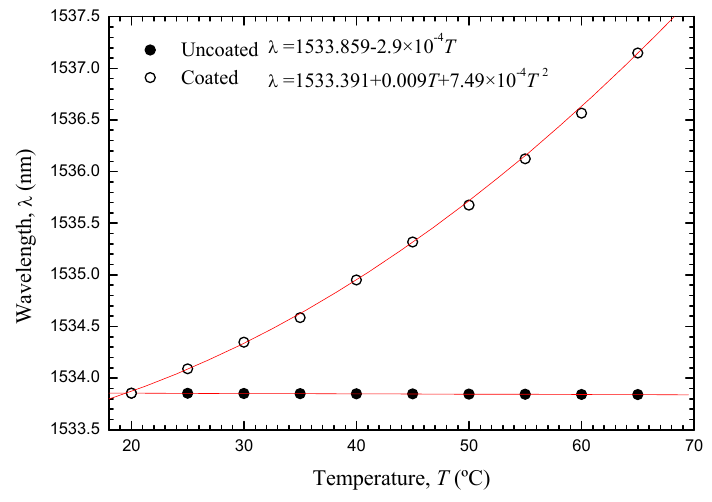
Figure 7. Temperature response of the Hi-Bi PCF FLM.